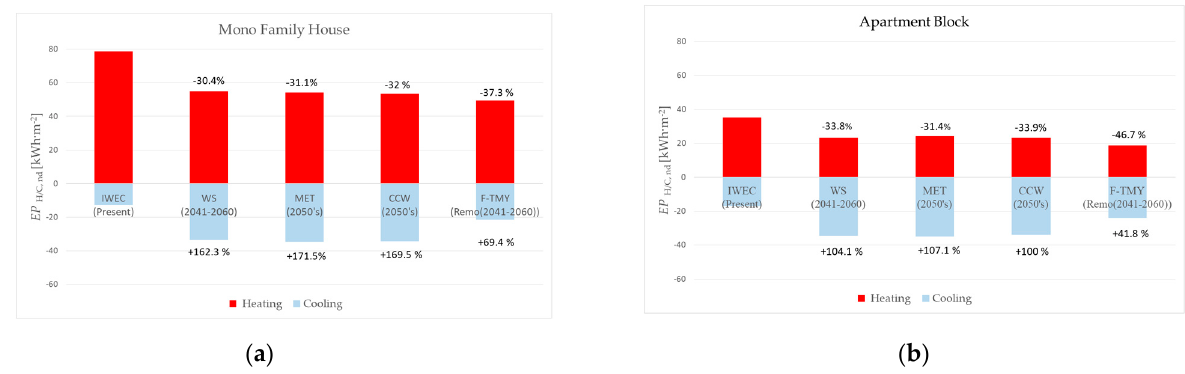
Figure 3. Net thermal energy needs for heating and cooling normalized by the conditioned floor area for a mono family house ( a ) and apartment block ( b ) for IWEC (Present), Weathershift (WS), Meteonorm (MET), CCWorldWeatehr-Gen (CCW), and F-TMY. All future weather files are for 2050s considering RCP 8.5.